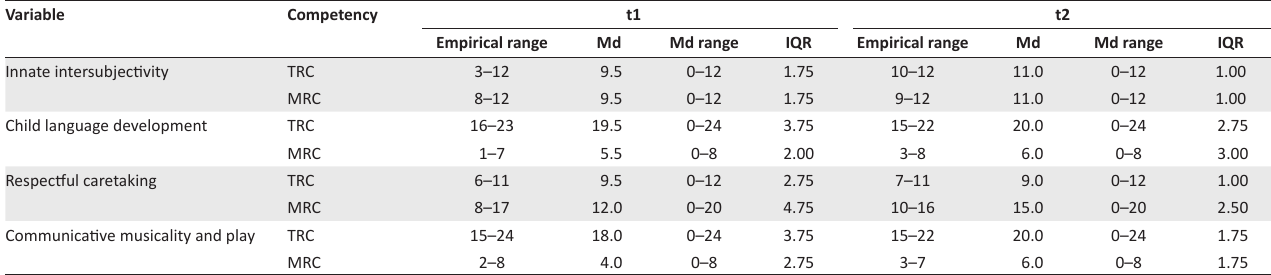
TABLE 5: Results of the module-specific analysis of the training topics.